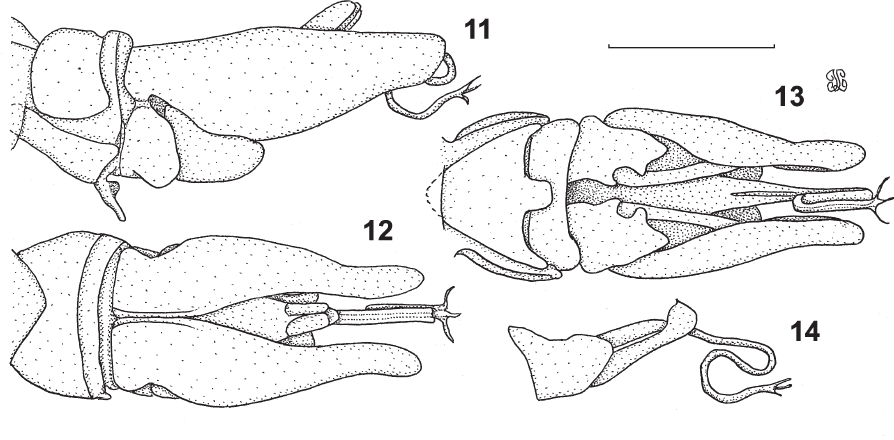
Figures 11–14. Gibbasilus condylus sp. n. ♂ terminalia, lateral ( 11 ), dorsal ( 12 ), ventral ( 13 ), detail of gonostylus and aedeagus ( 14